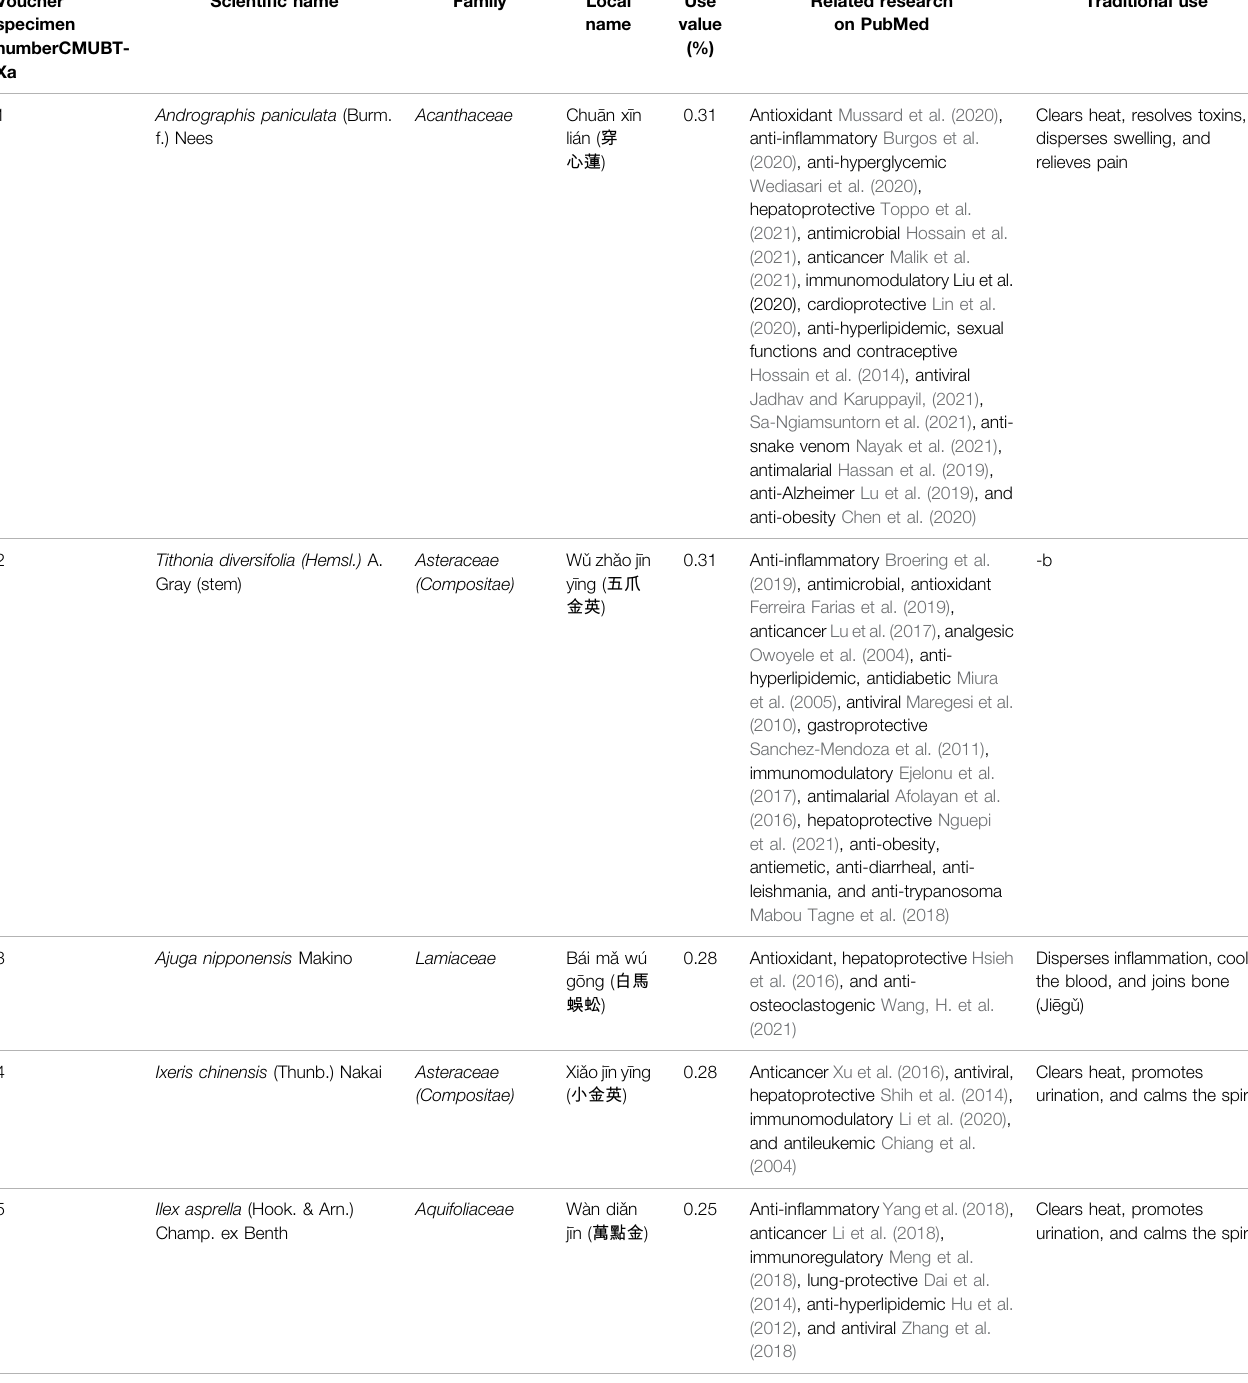
TABLE 1 | Modern pharmacological effects and traditional use of highly cited plant materials used in Taiwanese bitter tea (UV > 0.09). Voucher